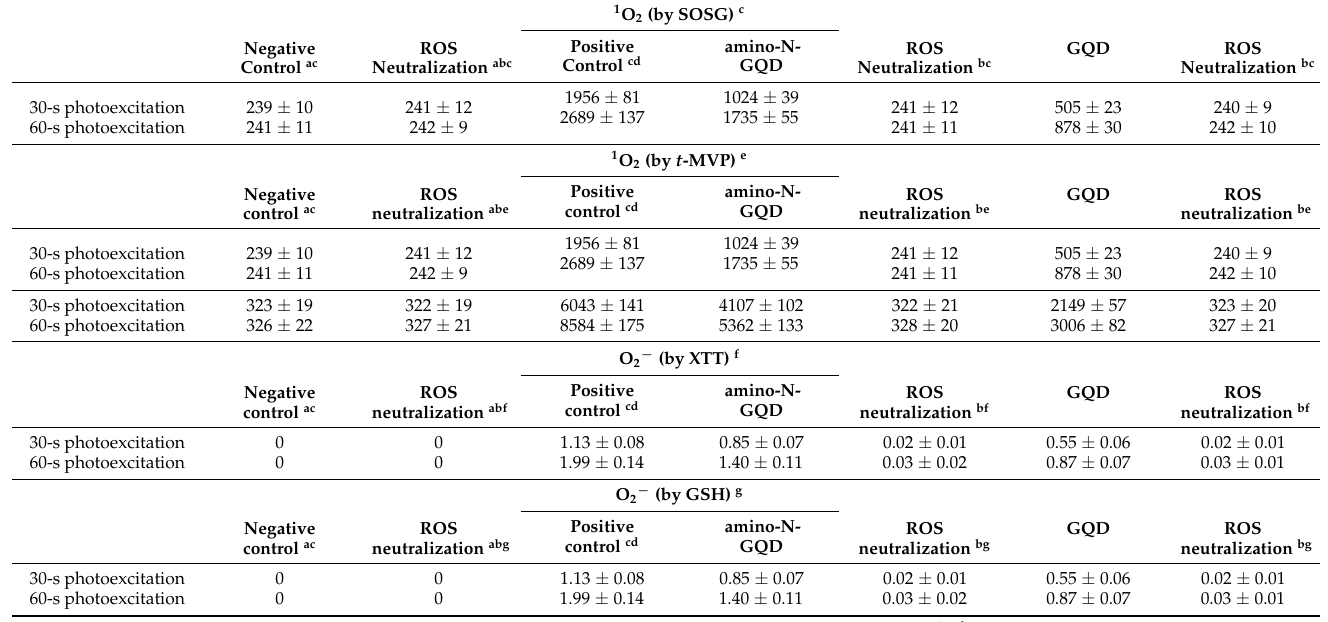
Table 2. Amount of ROS generated by conducting photoexcitation (0.07 W cm − 2 ; Ex: 670 nm) and by using materials–Ab- treated bacteria was maintained in the dark and monitored. Delivered dose: OD 600 = ~0.05 for MRSA and 0.5 µ g · mL − 1 for material. Data are presented as mean ± SD ( n = 6)